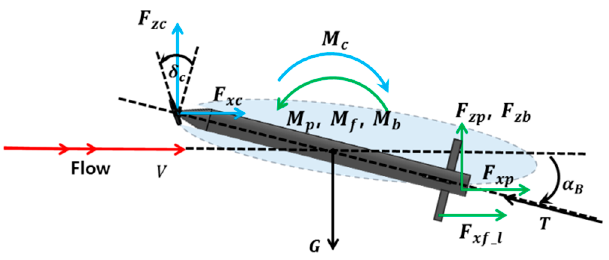
Figure 3. Free-body diagram of a supercavitating vehicle in a longitudinal vertical plane.